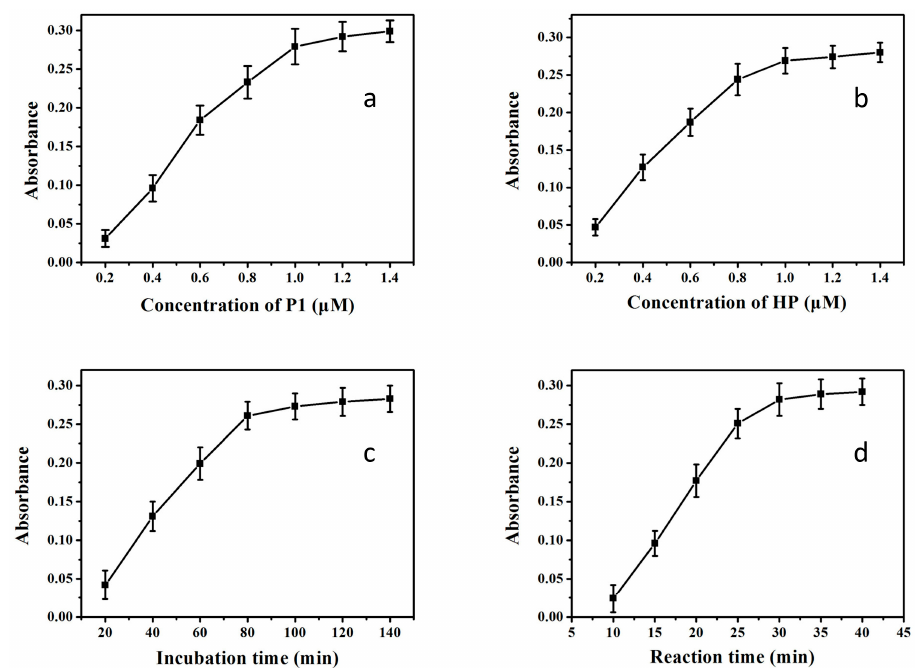
Figure 2. The optimization of concentration of ( a ) P1 and ( b ) HP, ( c ) the incubation time for the resulting mixture and HP, and ( d ) the digestion time for Ac II. The concentration of T1 was 0.2 nM. The error bars represent the standard deviations of three repeated experiments and the same below.